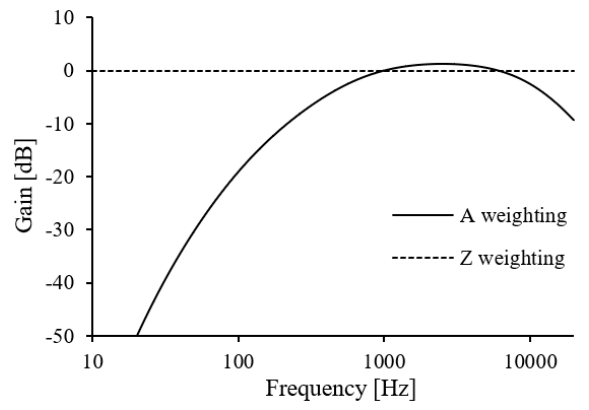
Figure 5. A and Z weighting functions.